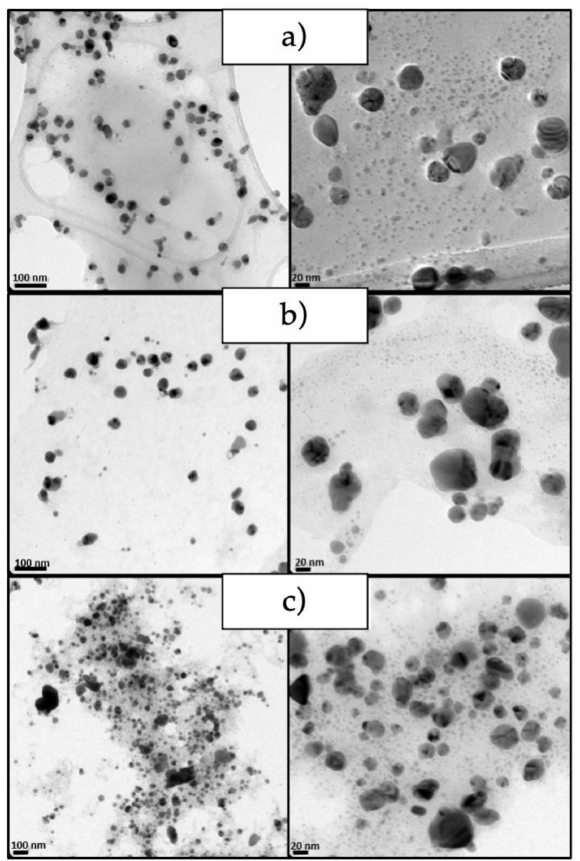
Figure 3. TEM micrograph of the synthesized AgNPs at different reaction conditions ( a ) AgNO 3 1 mM/8 h ( b ) AgNO 3 2 mM/8 h ( c ) AgNO 3 4 mM/8 h. Scale of 100 nm ( left ) and 20 nm ( right